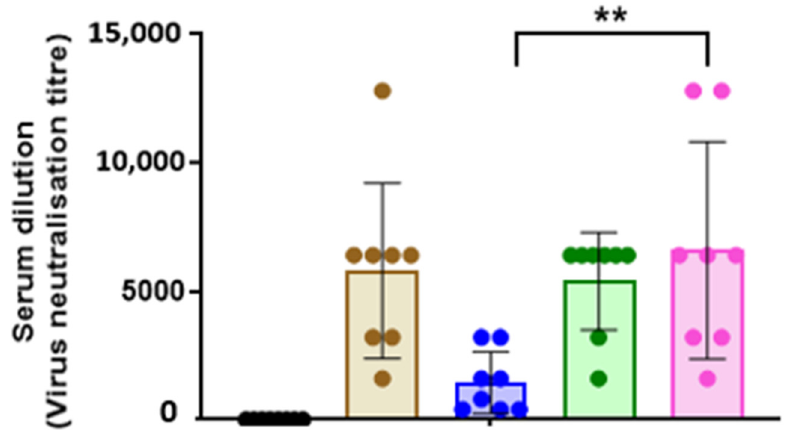
Figure 8. Virus neutralising antibody titre in the serum of chickens vaccinated with 35 µ g dose of rH9HA, rH9HA-Dec205 scFv, rH9HA-CD11c scFv, and inactivated H9N2 vaccines. Virus micro- neutralisation assay was carried out on day 28 post primary vaccination serum samples. The serum was first inactivated at 56 ◦ C for 30 min and two-fold serum dilutions were made. Then, the inactivated serum was incubated with 150 TCID 50 of H9N2 virus (UDL 01/08) for 1 h at 37 ◦ C. The virus/serum mixture was then added onto the MDCK cells and further incubated for 1 h at 37 ◦ C. This was followed by the removal of the virus-serum mixture from the cells and incubation with fresh media containing 2 µ g/mL TPCK trypsin for about 3 days. The virus neutralisation titre was expressed as the reciprocal of the highest serum dilution at which virus infection is blocked and the cells survive. Data are presented as mean ± SD and analysed by one-way ANOVA followed by Tukey’s multiple comparison test. ** p < 0.01.